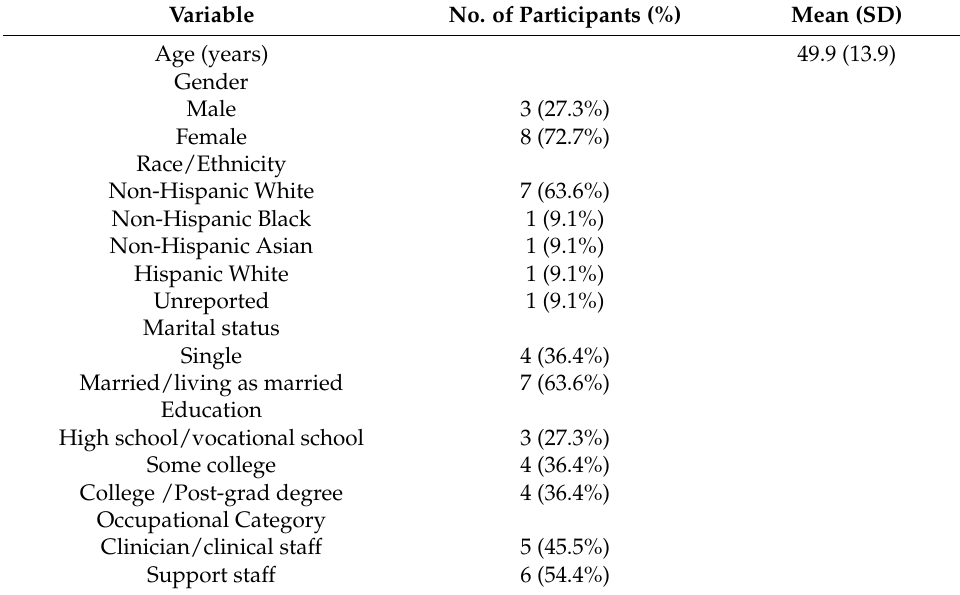
Table 2. Participant Characteristics ( n =